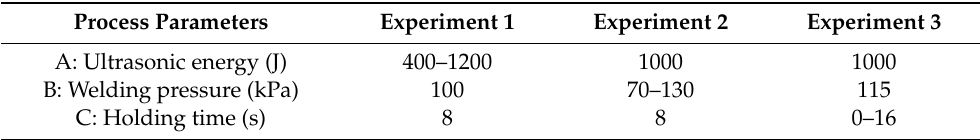
Table 1. Process parameters used in experiments.